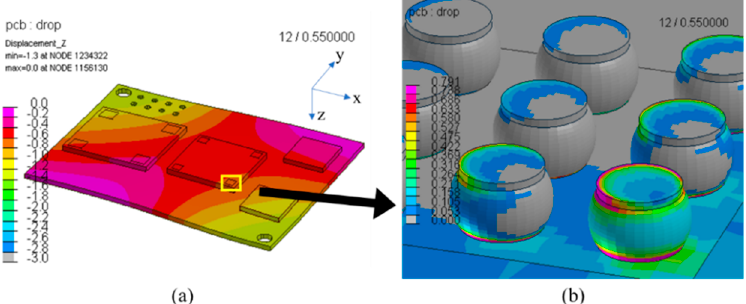
Figure 13. FEA result of the PBA (0.6 mm thick PCB) with fixture I: ( a ) out-of-plane deformation contour, ( b ) principal stress (GPa) distribution under BGA package ②.